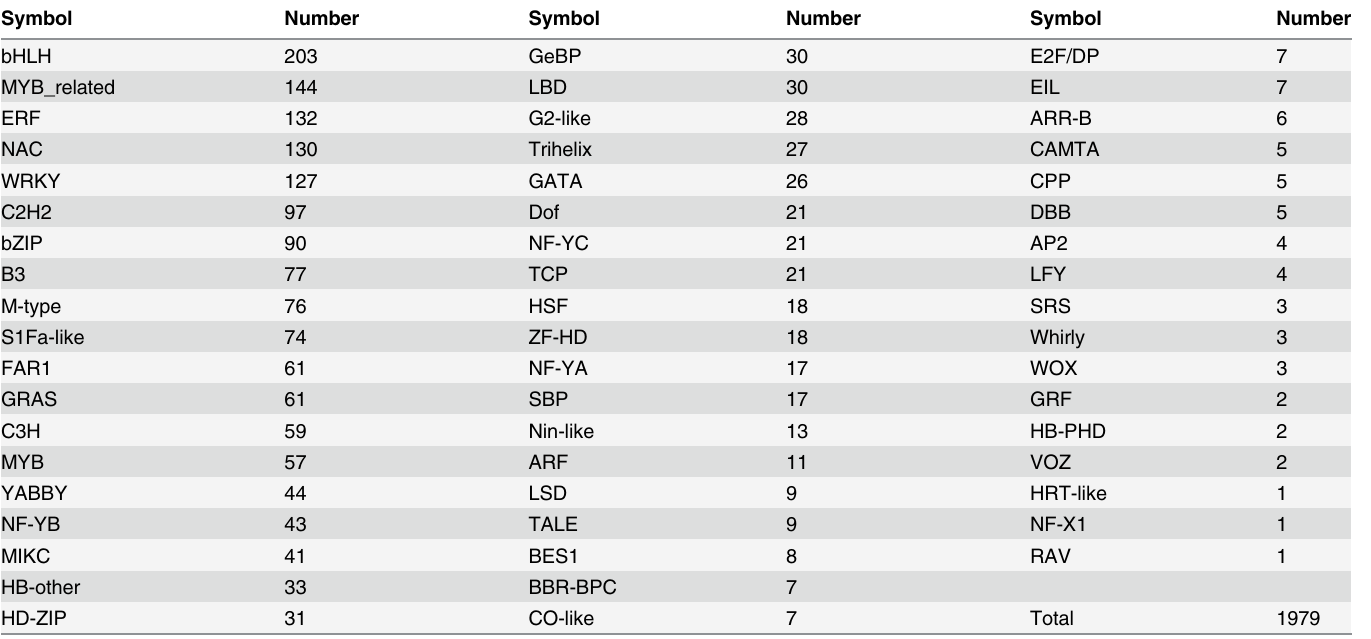
Table 3. Distribution of transcription factors by gene family.